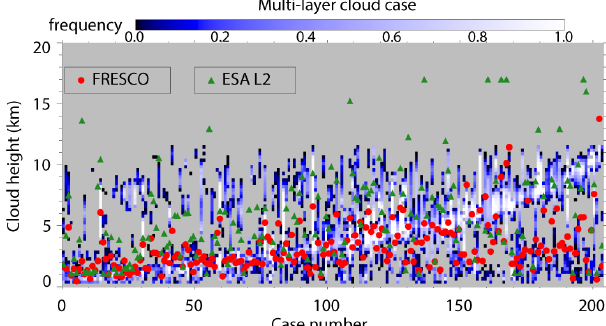
Figure 11. Comparison between the SCIAMACHY ESA L2 cloud top height, the FRESCO cloud height, and the Cloudnet cloud height distribution for multilayer clouds. The cases are sorted ac- cording to the Cloudnet cloud middle height. The Cloudnet cloud height distribution is normalized to 1 and indicated with a blue- white color (color code given by the horizontal bar). Here the cases with FRESCO effective cloud fraction below 0.1 are